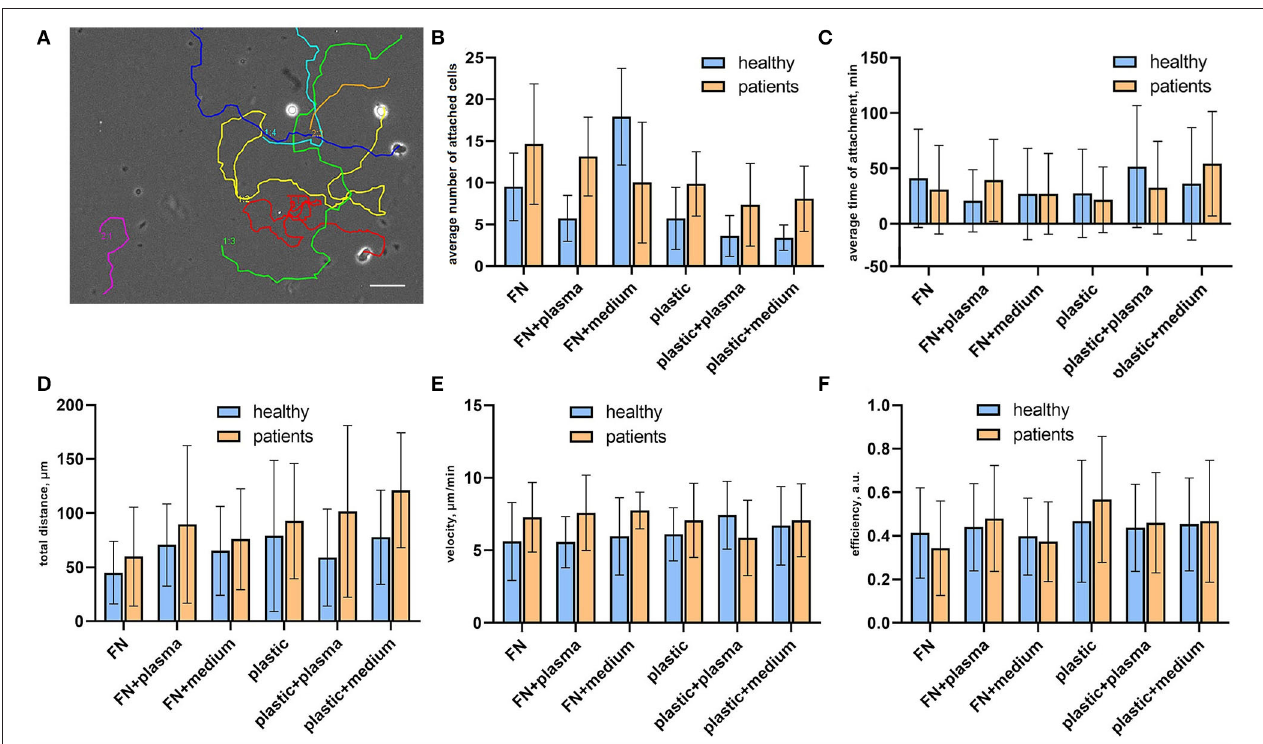
FIGURE 2 | Random migration assay for sorted CTLs. (A) Representative migration tracks from a phase contrast time-lapse video summarized and plotted on one frame. Each video lasted for no < 2h with inter-frame interval of 30s. (B) Cell adhesiveness in the tested conditions expressed as average number of attached cells per observation period. The data was obtained from phase contrast time-lapse videos. The number of attached cells was elevated in all samples from patients compared to healthy donors, the difference was statistically significant ( p = 0.02, mixed 2-way ANOVA model) irrespective of substrate type or source of soluble ligands. (C) Cell adhesiveness in the tested conditions is expressed as the average time of attachment for attached cells. The time of the attachment was assessed as the time interval between the first frame with the cell attached to the substrate and the frame where it is detached. The data was obtained from phase contrast time-lapse videos. (D) Total migration distance of attached CTLs calculated as a displacement that a cell made during the time-lapse video, at least 20 cells were analyzed per experimental condition for each donor/patient. Each video lasted for no < 2h with an inter-frame interval of 30s. (E) Medium cell velocity of attached CTLs calculated by dividing the track distance by track time. The data was obtained from phase contrast time-lapse videos, each video lasted for no < 2h with inter-frame interval of 30s. At least 20 cells were analyzed per experimental condition for each donor/patient. (F) Migration efficiency of attached CTLs calculated by dividing the total distance by track distance. The data was obtained from phase contrast time-lapse videos, each video lasted for no < 2h with an inter-frame interval of 30s. At least 20 cells were analyzed per experimental condition for each